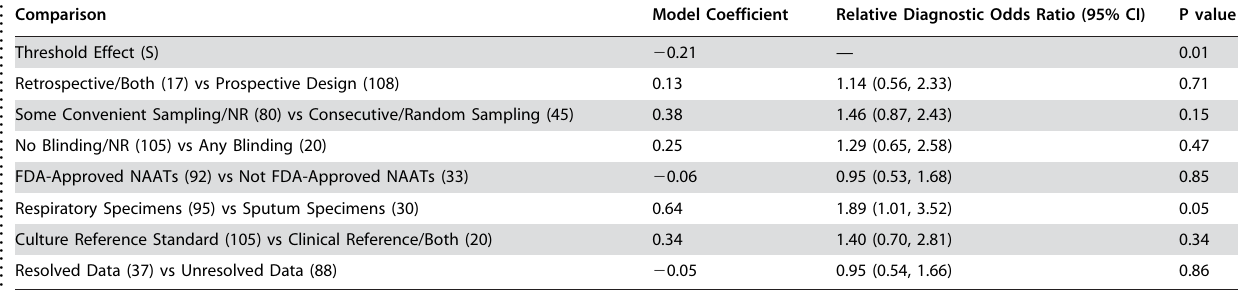
Table 6. Results from Meta-Regression Analysis Using the Restricted Maximum Likelihood Method .. ... .... ... ... .... ... ... .... ... ... .... ... ... .... ... ... .... ... ... .... ... ... .... ... ... .... ... ... .... ... ... .... ... ... .... ... ... .... ... ... .... ... ... .